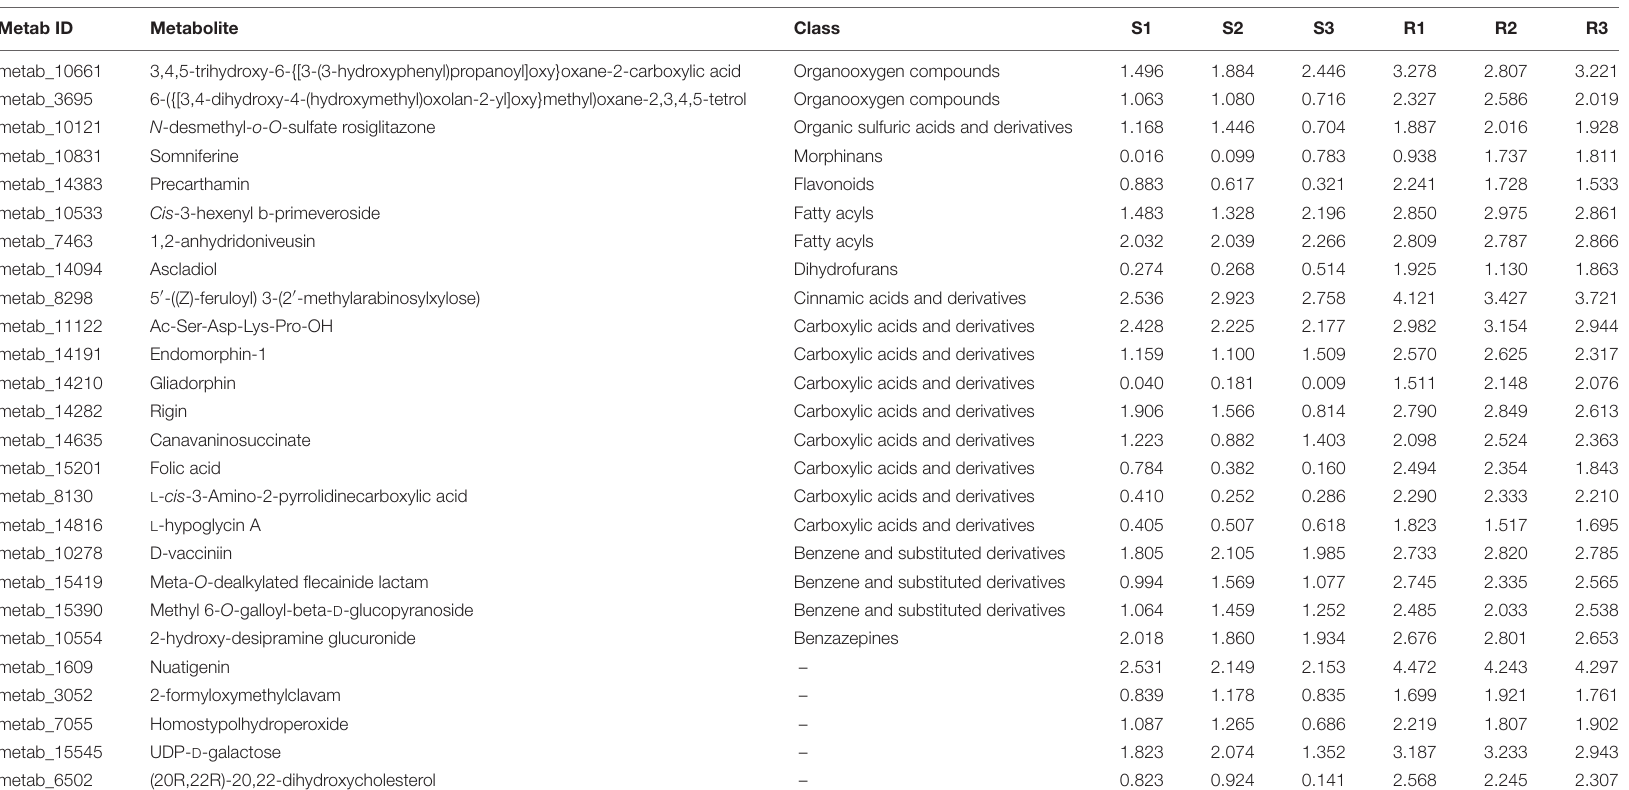
Methyl 6- O -galloyl-beta- D